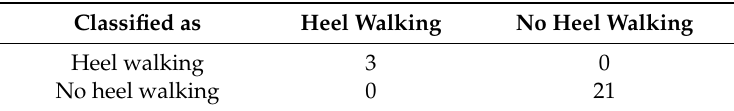
Table 3. J48 classification results.